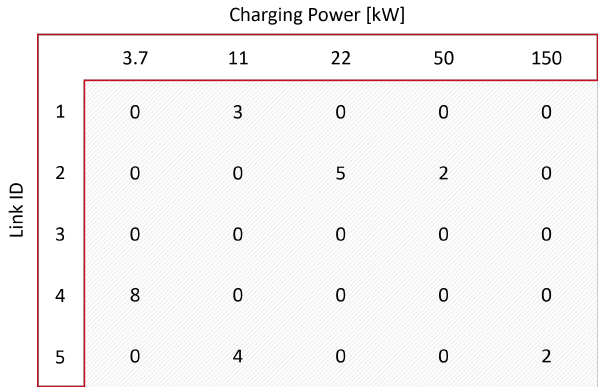
Figure 3. Example of a